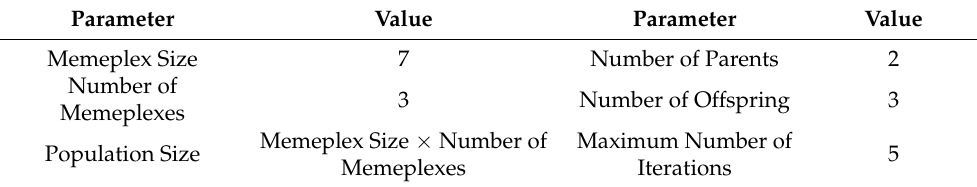
Table 7. Shuffled frog-leaping